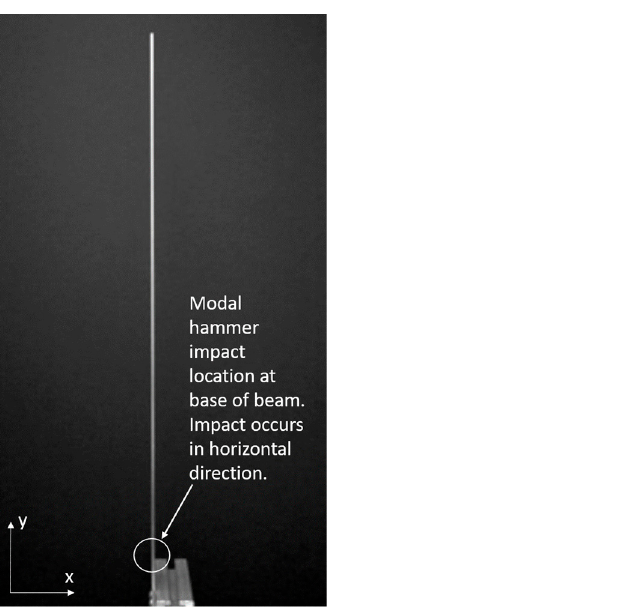
Figure 9. Cantilever beam experimental setup.